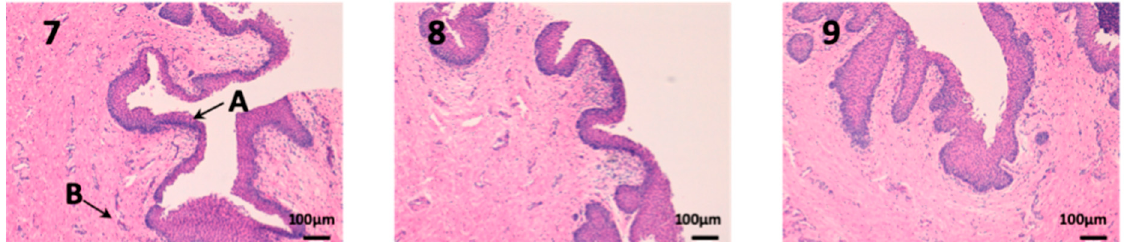
Figure 10. Photo 7: Histological image of untreated vaginal mucous observed at 400× ; Photo 8: Histological image of vaginal mucous treated with CP-Solution observed at 400× ; Photo 9: Histological image of vaginal mucous treated with CP-NPs observed at 400× . (A) Stratified flat keratinized epithelium; (B) own laminate.